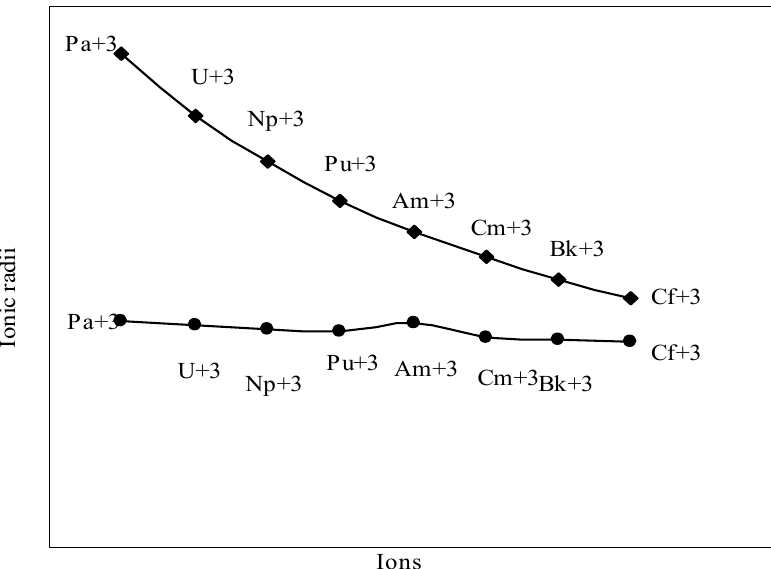
Figure 7. Plot of radii of tripositive ions of actinide (5-f block)